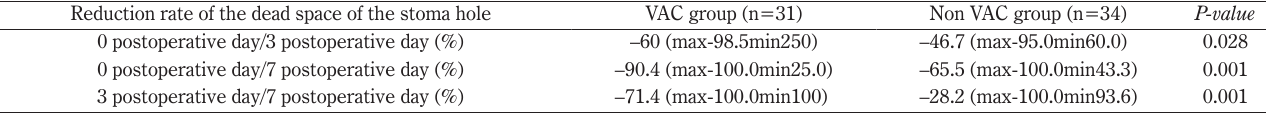
Table 4 Reduction rate of dead space of stoma